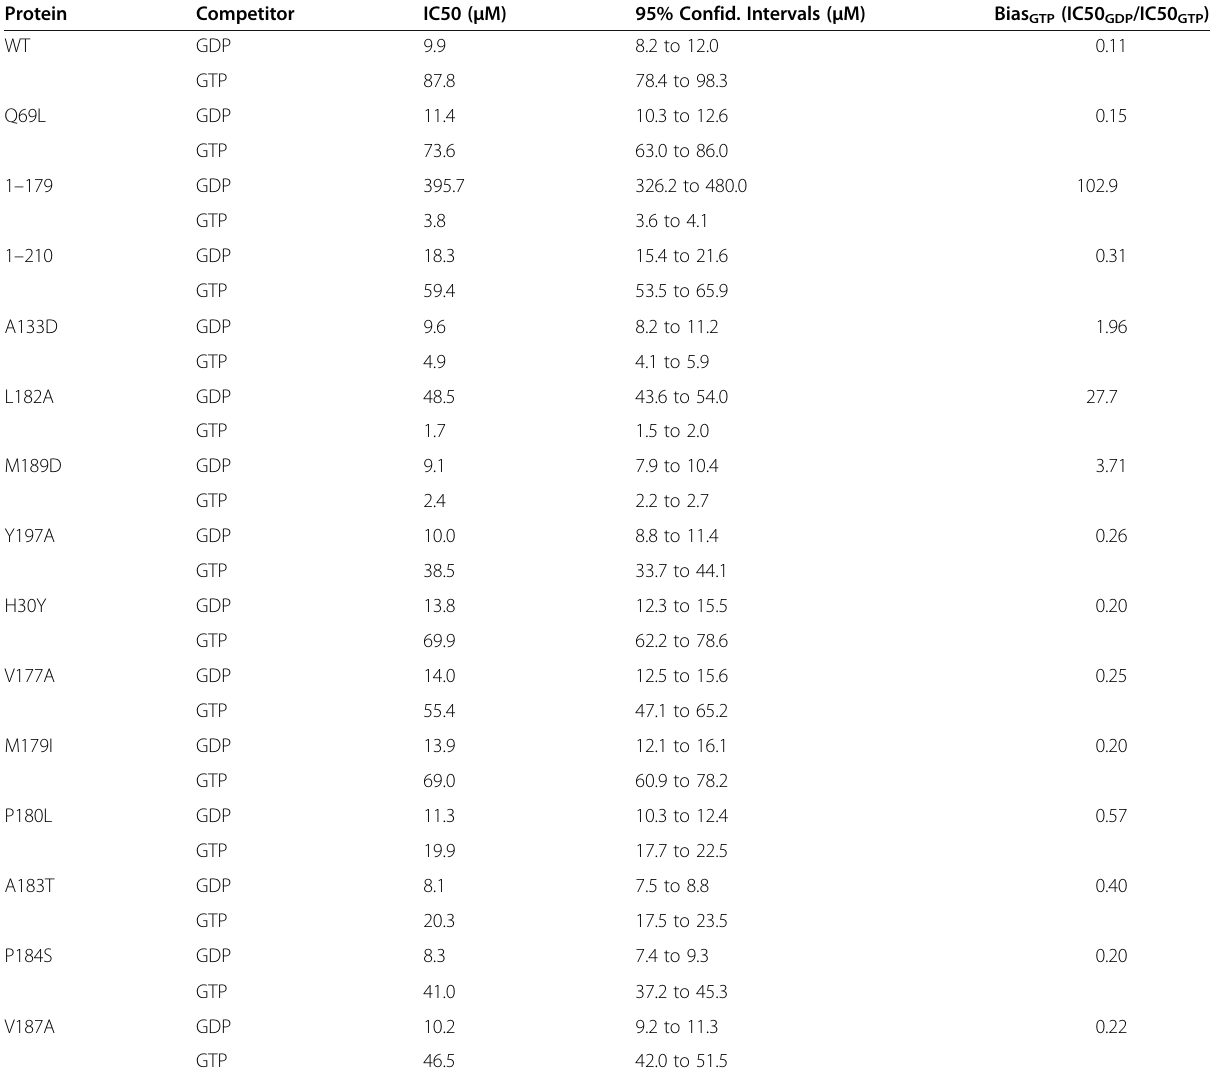
Table 1 GDP/GTP binding preference (Bias GTP ) of different Ran mutants. A larger value of Bias GTP indicates that the protein more preferentially binds GTP. Bias GTP value of 1 means binding GDP or GTP at equal affinity